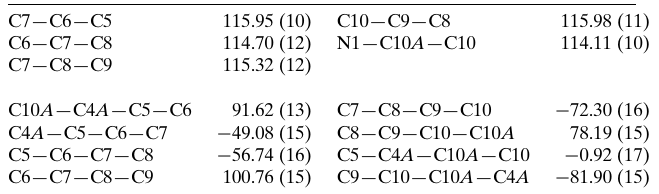
Table 3 Selected bond and torsion angles ( (cid:3) ) for 1c .